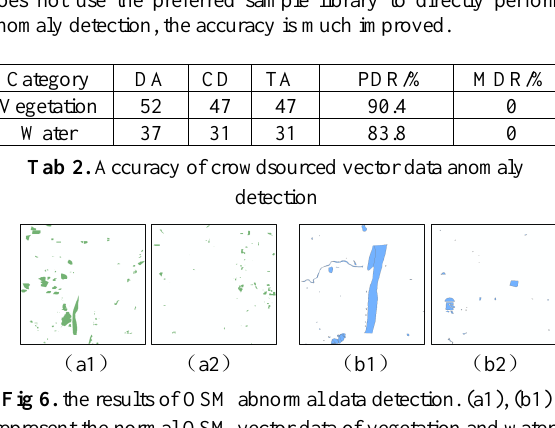
Fig 7. Abnormal data detection results